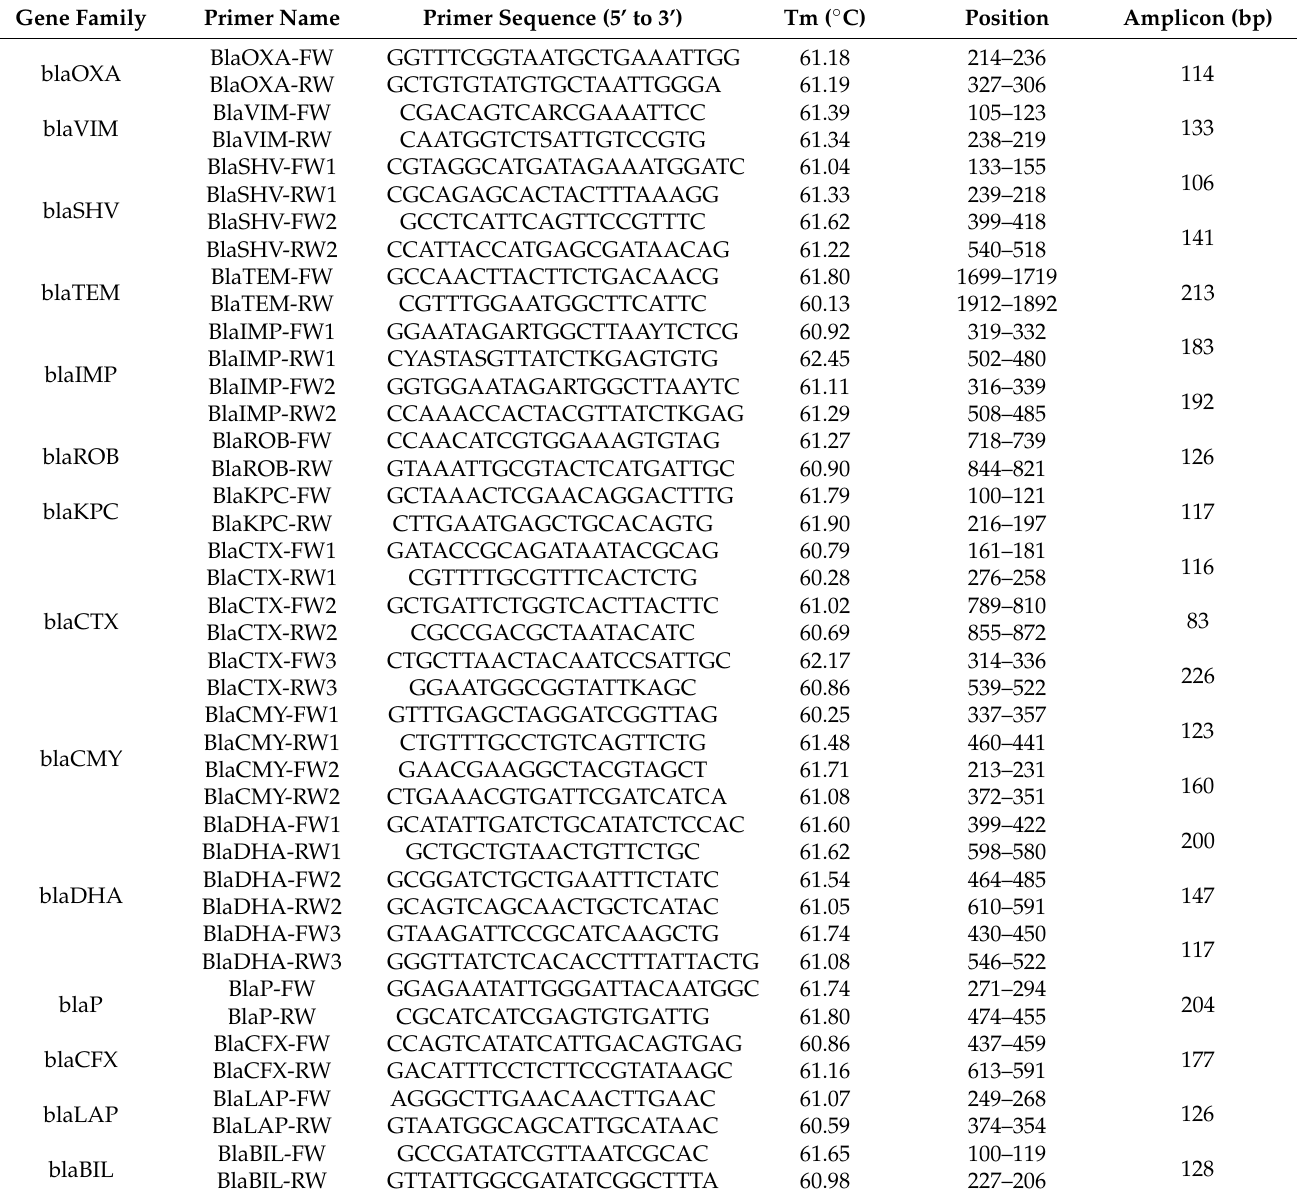
Table 7. Primers sequences and amplicon size for beta-lactamase gene family